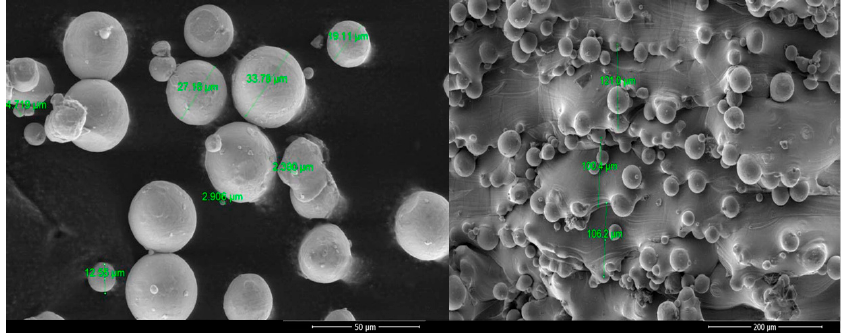
Figure 5. SEM images of the Ti6Al4V alloy powder and the surface of the Ti6Al4V implants.